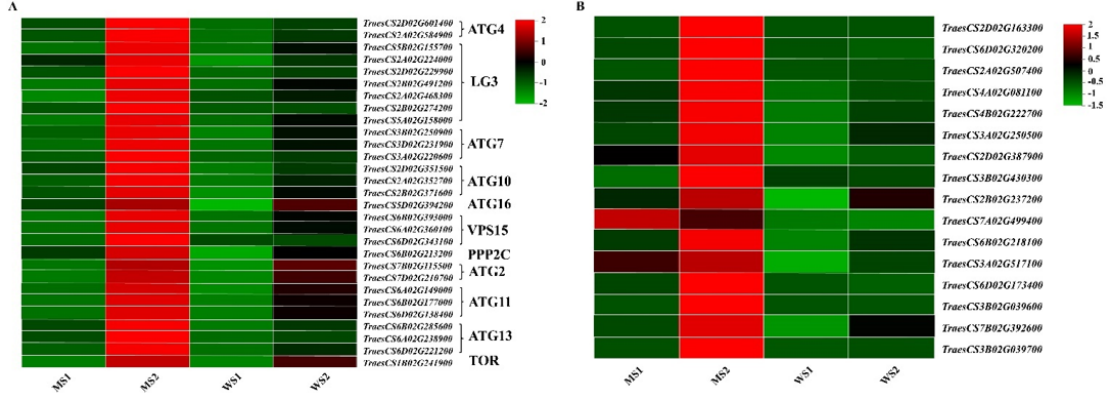
Figure 8. Expression profile clustering of autophagy related genes. The expression ratio is standard- ized based on normalized transcripts per kilobase million (TPM) values, where each vertical column represents the mean of three samples (MS1, MS2, WS1 and WS2), and each horizontal row repre- sents a sample single gene.